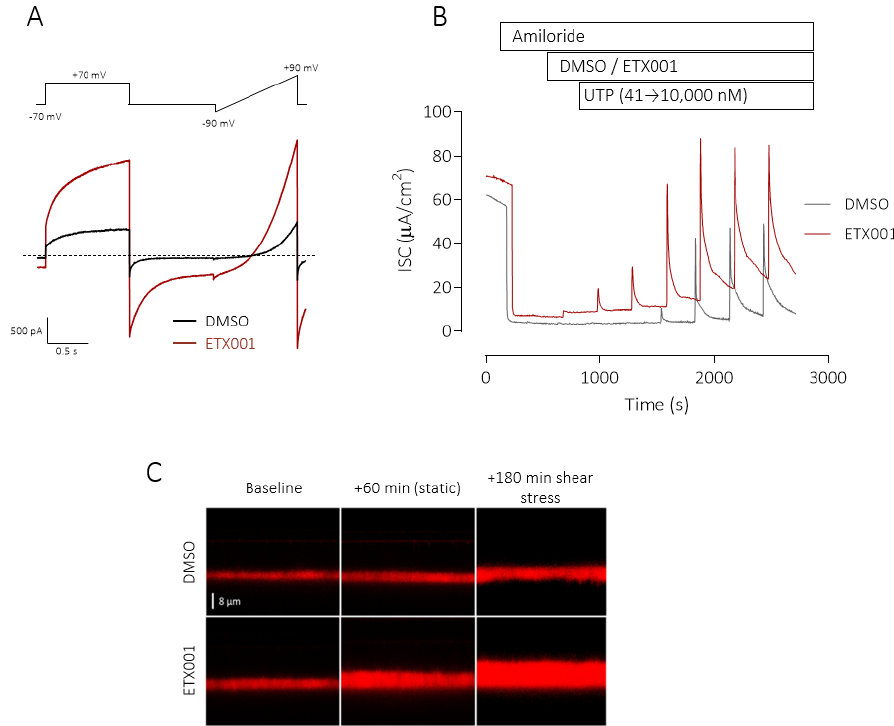
Figure 3. ETX001 potentiates TMEM16A function in recombinant and primary human cell systems. Whole-cell patch-clamp electrophysiological recordings from FRT cells stably expressing hTMEM16A ( A ) in the absence (black lines) and presence (red lines) of ETX001 (1.1 µ M). Dotted line indicates the zero-current level. Sample raw data trace illustrating the e ff ects of ETX001 (1 µ M) upon the UTP-stimulated anion current response ( B ). After inhibition of the ENaC current with amiloride (10 µ M), inserts were treated with either DMSO (grey dotted trace) or 1 µ M ETX001 (red line) prior to the cumulative addition of increasing concentrations of UTP. ( C ) Sample XZ confocal images of airway surface liquid (ASL) visualised using Texas red staining in the absence and presence of ETX001 (1 µ M). The change in ASL height from baseline was measured following a 1 h treatment with ETX001 or vehicle under “static conditions”, i.e., no shear stress, and also after 3 h of continual